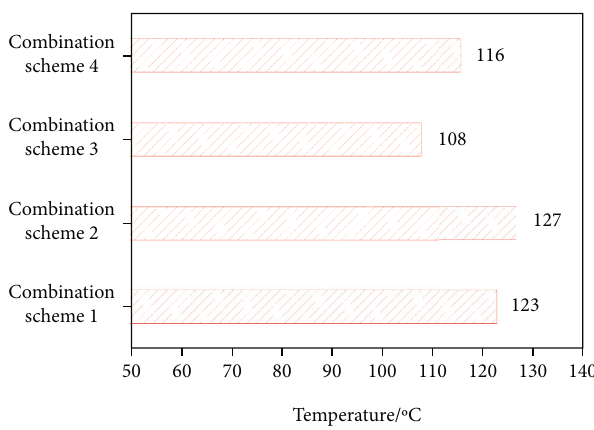
Figure 8: In fl uence of di ff erent catalyst combination schemes on the curing temperature